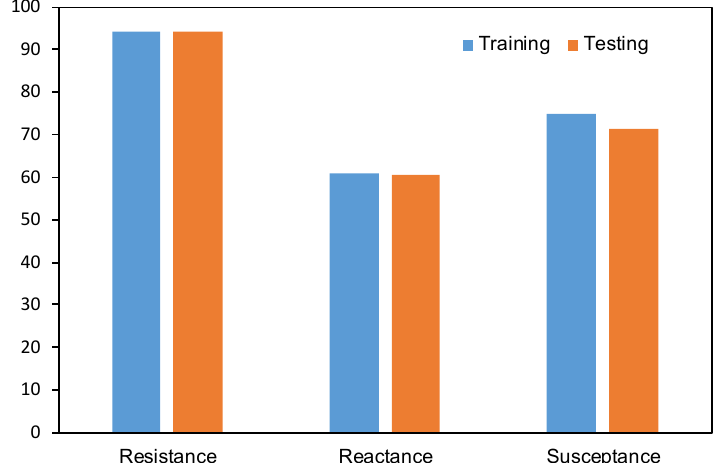
Figure 18. Comparison of the accuracies of the network trained on three response types of the smart strand.